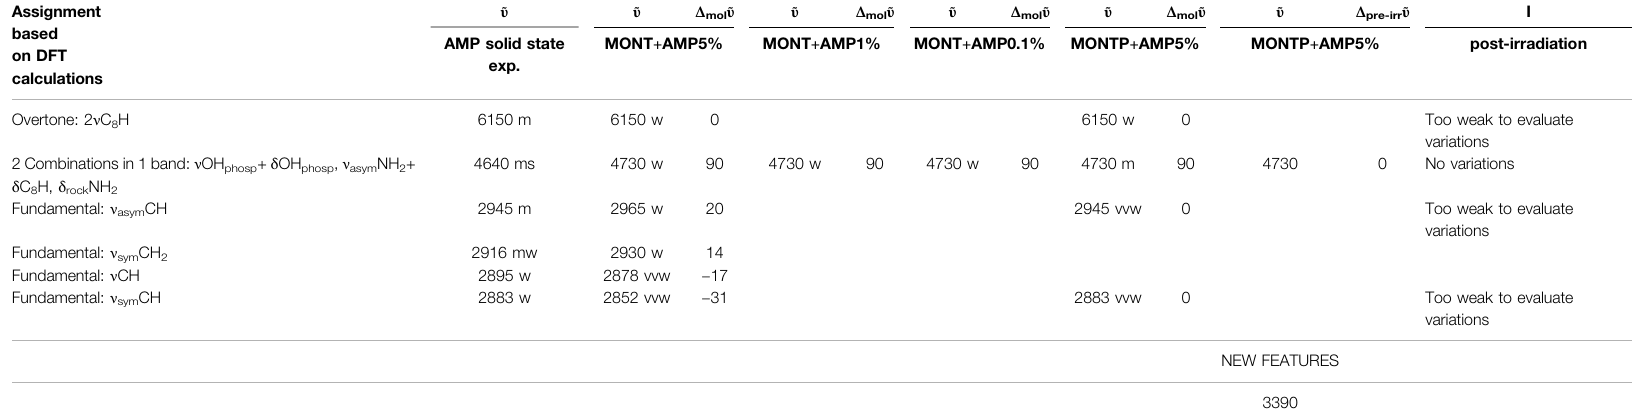
TABLE 1 | Changes of molecular NIR features due to adsorption onto montmorillonite at different concentrations (5, 1 and 0.1 wt%), presence of 1 wt% of magnesium perchlorate and 70 min of UV irradiation. Assignment based on DFT